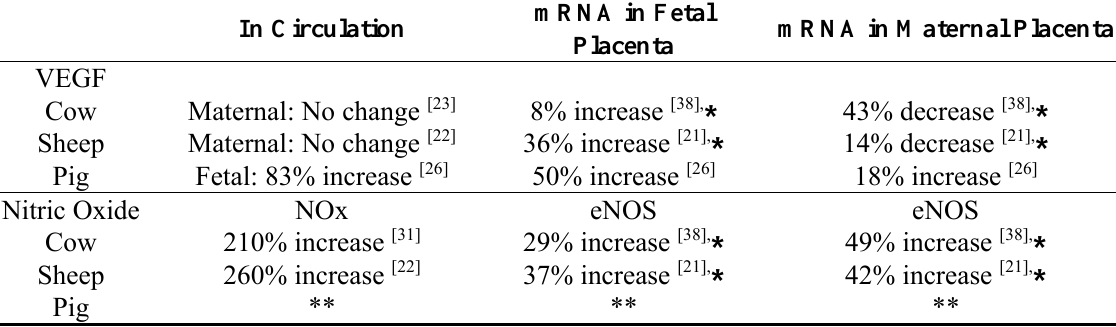
Table 1. Changes in VEGF protein and placental mRNA as well as nitric oxide metabolite (NOx) and eNOS mRNA from mid- to late-gestation in cattle, sheep, and swine. mRNA in Fetal mRNA in Maternal Placenta In Circulation Placenta VEGF Cow Maternal: No change [23] 8% increase [38], * 43% decrease [38], * Sheep Maternal: No change [22] 36% increase [21], * 14% decrease [21], * Pig Fetal: 83% increase [26] 50% increase [26] 18% increase [26] Nitric Oxide NOx eNOS eNOS Cow 210% increase [31] 29% increase [38], * 49% increase [38], * Sheep 260% increase [22] 37% increase [21], * 42% increase [21], * Pig ** ** ** *Not significant at p ≤ 0.05; **